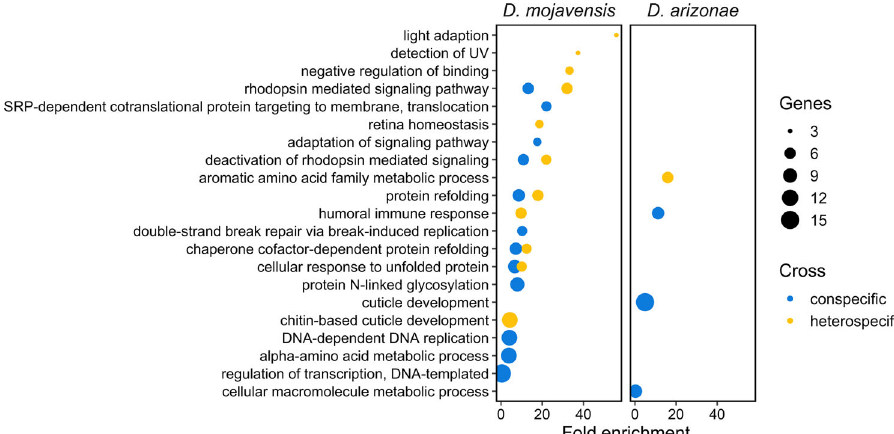
Fig. 5 Gene ontology analysis of DE genes. Functional analysis for signi fi cant DE genes, indicating distinct biological process gene ontology enrichment categories between the species for genes differentially regulated relative to virgins in con- and heterospeci fi c crosses. The fold enrichment of detected genes within each enriched category is